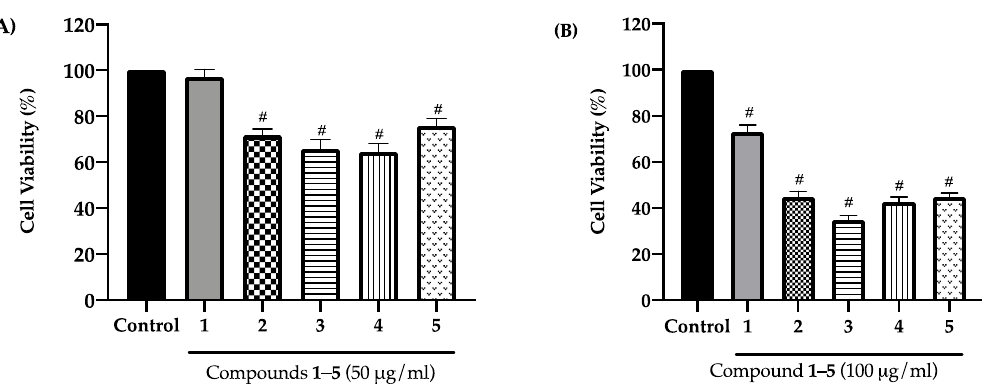
Figure 1. Structures of compounds 1–5 isolated from the EtOAc extract of D. pachyglossum.